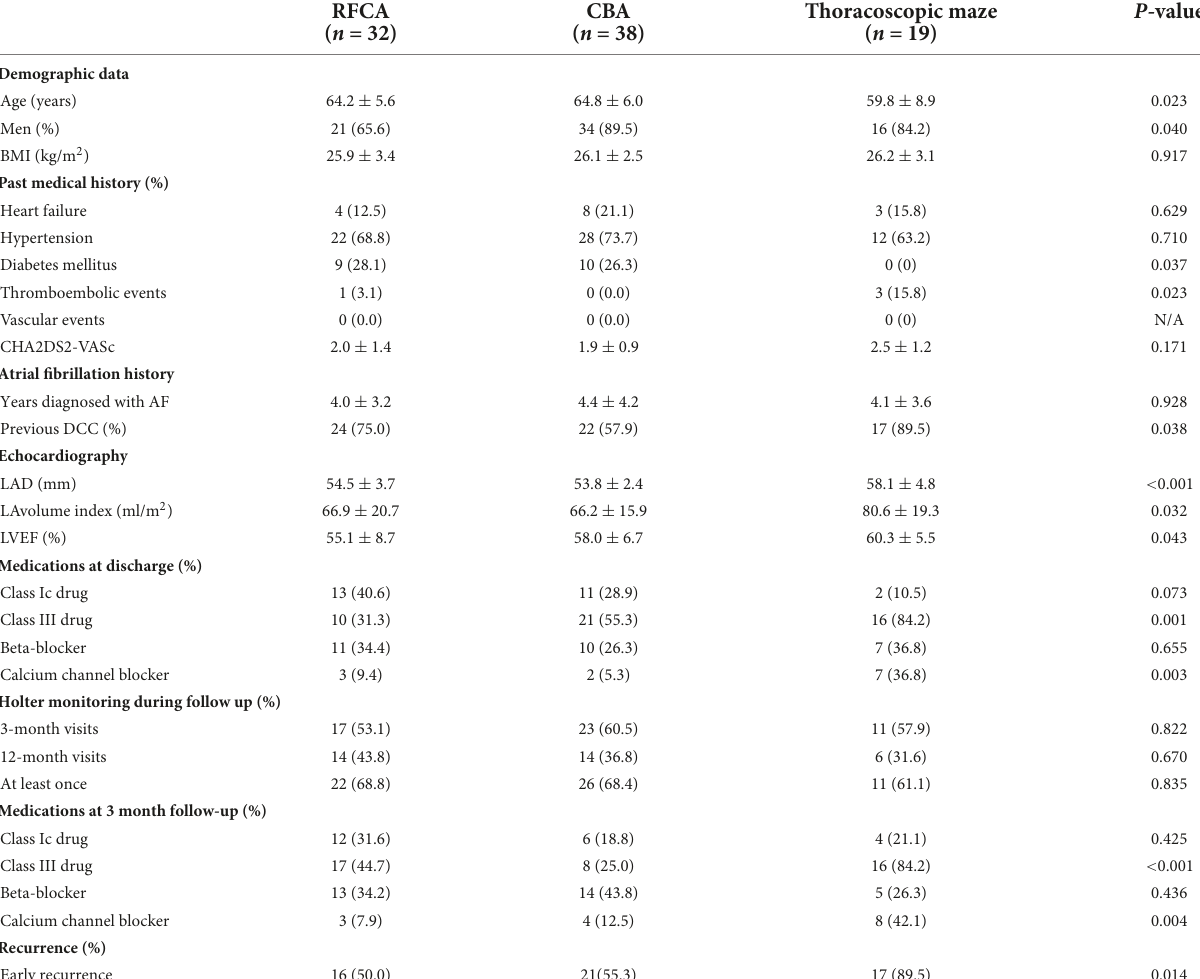
TABLE 1 Baseline characteristics of PeAF patients with large LA.